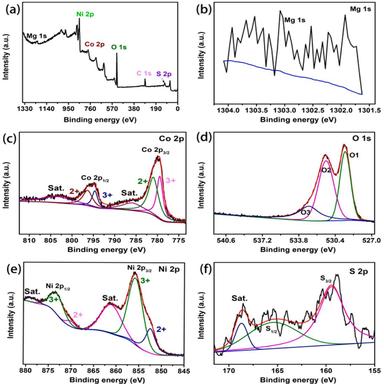
(a) XPS wide scan survey spectra of the MCO@NS electrodes. High-resolution XPS spectra of (b) Mg 1s, (c) Co 2p, (d) O 1s, (e) Ni 2p and (f) S 2p for the MCO@NS electrode.